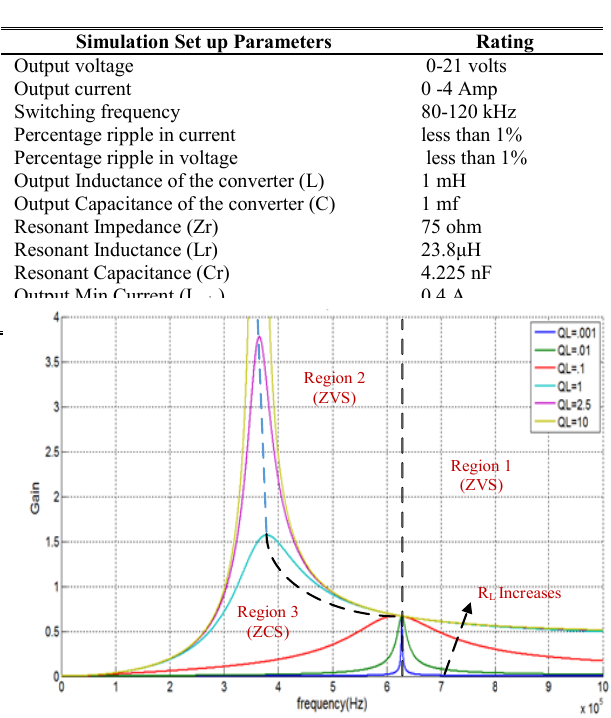
Table 2. Simulation Parameters of Quasi Resonant Buck Converter